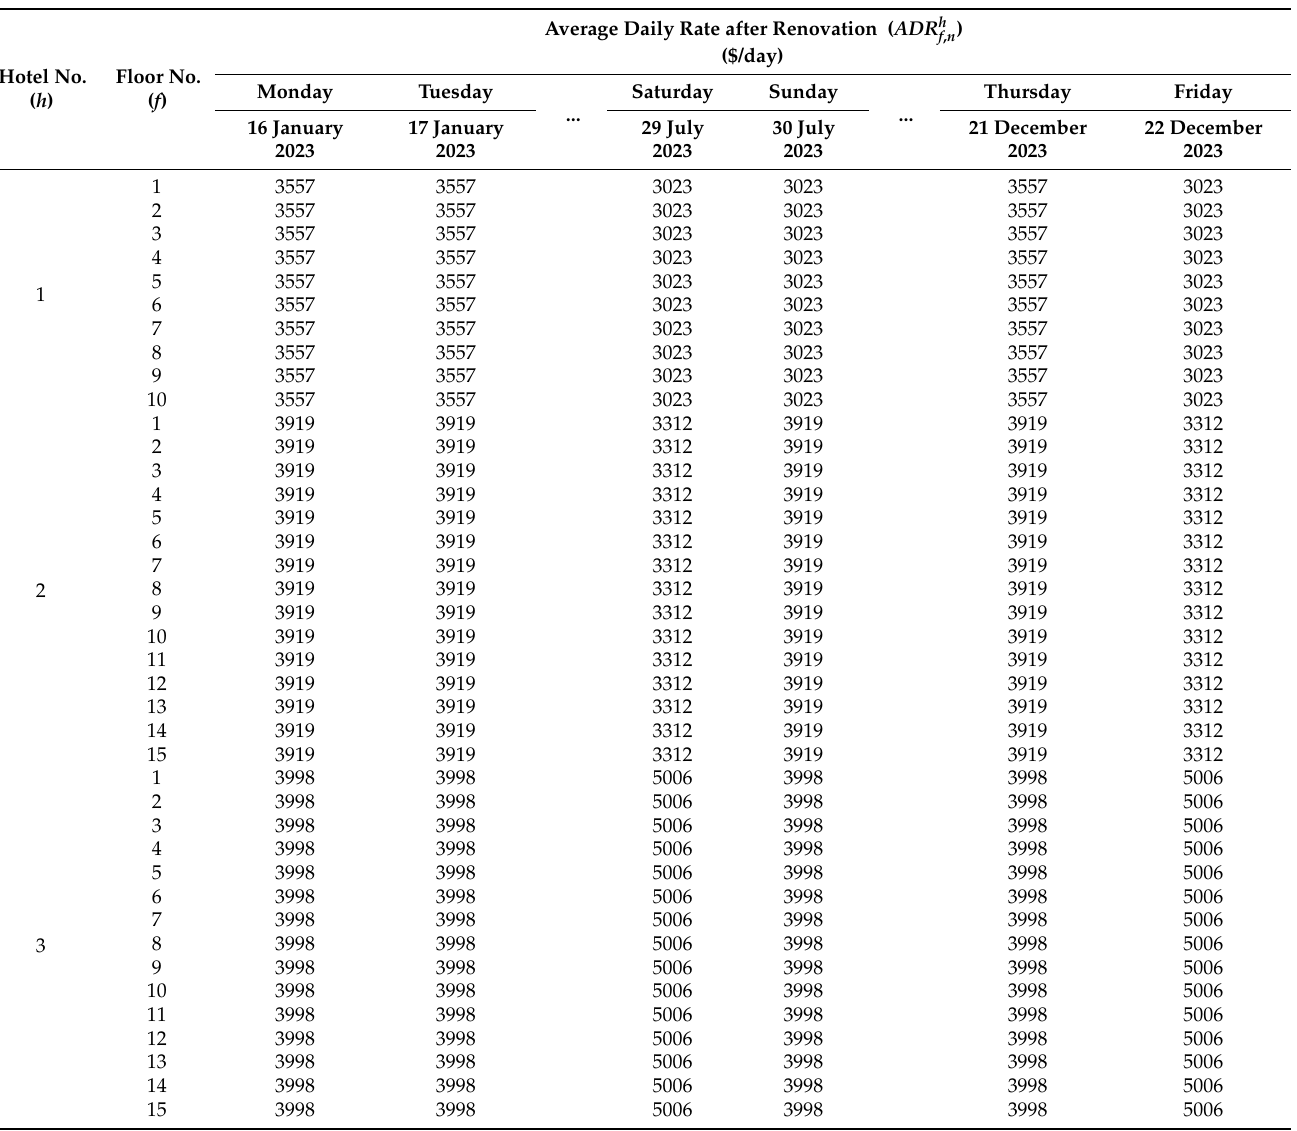
Table 7. Average daily rate after renovation for sample